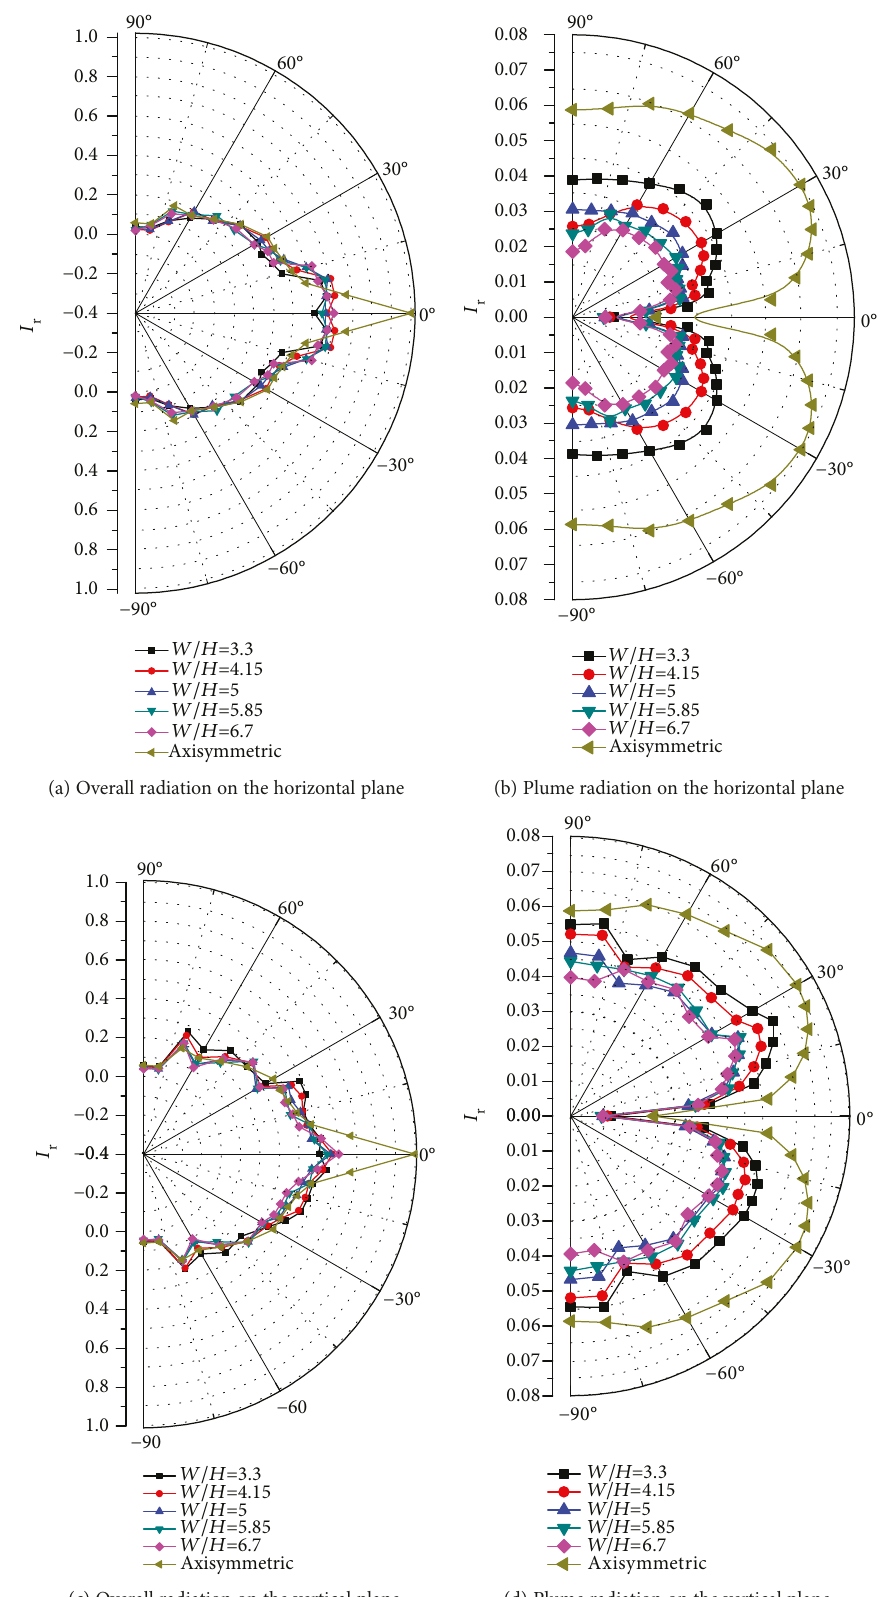
Figure 20: Infrared radiation of exhaust systems in the band of 3-5 μ m varying W / H